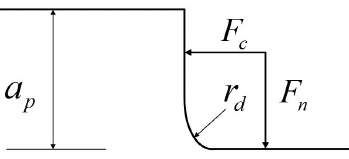
Figure 6. Stress concentration in the contact zone between work- piece and tool